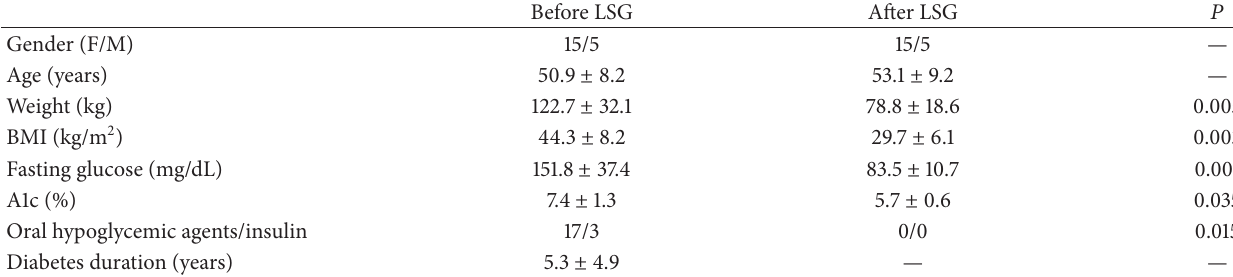
Table 1: Characteristics of morbidly obese patients with T2DM before and after LSG at time of CGM. Before